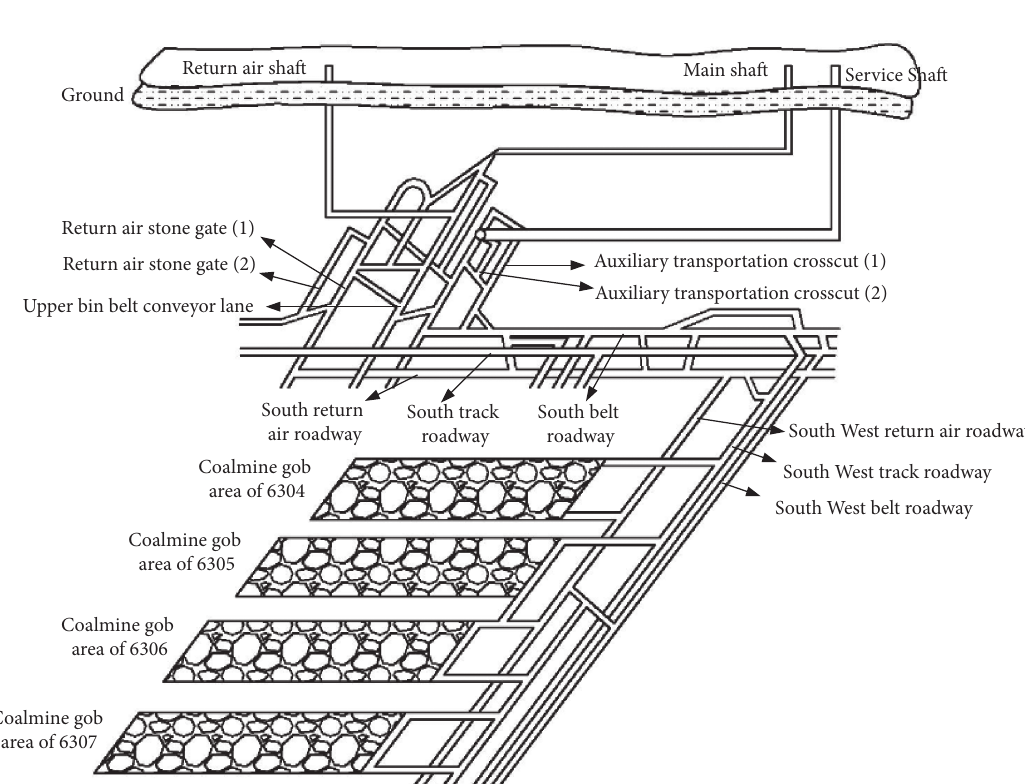
Figure 2: Three-dimensional schematic diagram of ventilation system in south wing shaft